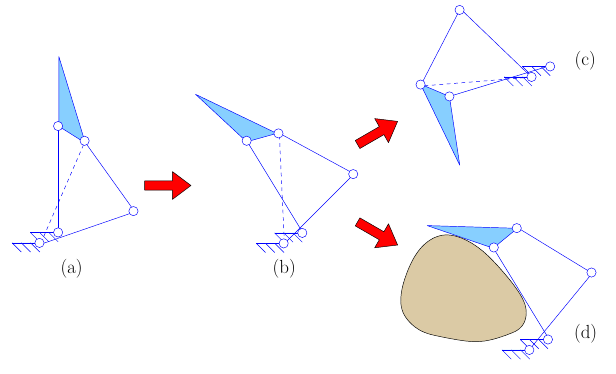
Figure 14. Possible closing motions of the optimized finger.